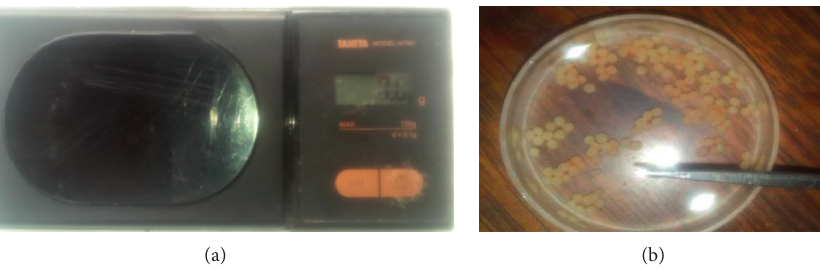
Figure 3: (a) Electronic scale, (b) oocyte counting device.